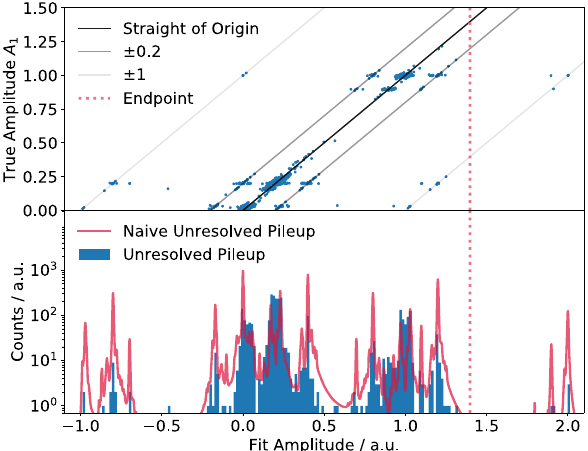
Fig. 12 Upper panel: scatter plot of fit amplitude and true amplitude A 1 of each simulated unresolved pileup event. Most events are dis- tributed around the straight of slope 1 through the origin. Additionally, straights of slope 1 shifted by ± 0 . 2 and ± 1 are drawn to guide the eye. Lower panel: histogram of the fit amplitudes of the events above. The autoconvolution of the theoretical 163 Ho spectrum for a pileup fraction of f pu = 3 × 10 − 6 is superimposed for comparison. In the simulated spectrum, structures from PIT with large amplitudes on the tail (e.g. at fit amplitude ∼ 2 . 0) are more than an order of magnitude smaller than in the autoconvolution spectrum. In turn, unresolved pileup with barely altered fit amplitudes are more abundant in the simulated